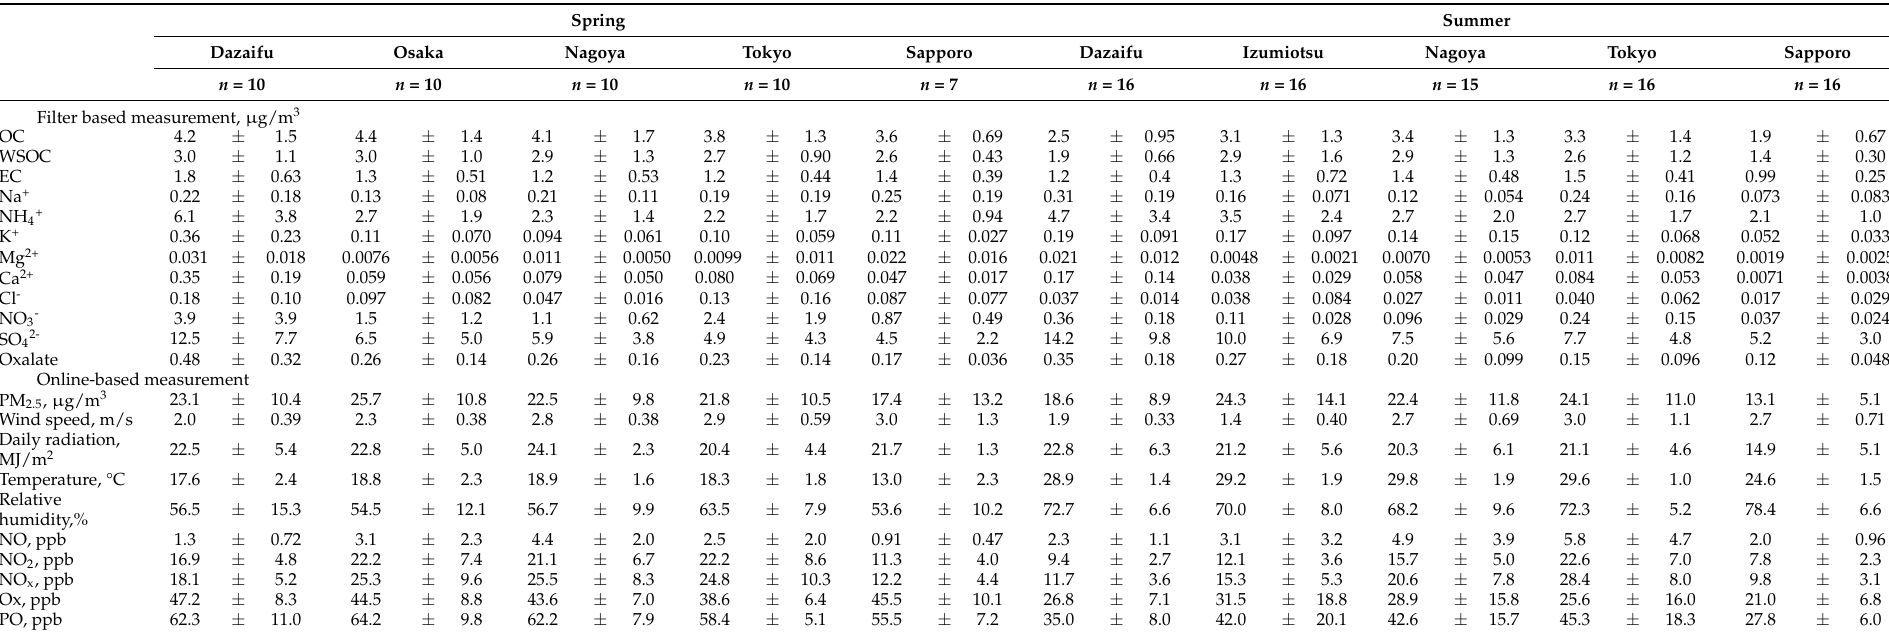
Table 2. Seasonal OC, WSOC, EC, and ion averages by filter-based measurements and PM 2.5 mass, meteorological data, gaseous components, and potential ozone (PO) by online-based measurements during spring and summer at all